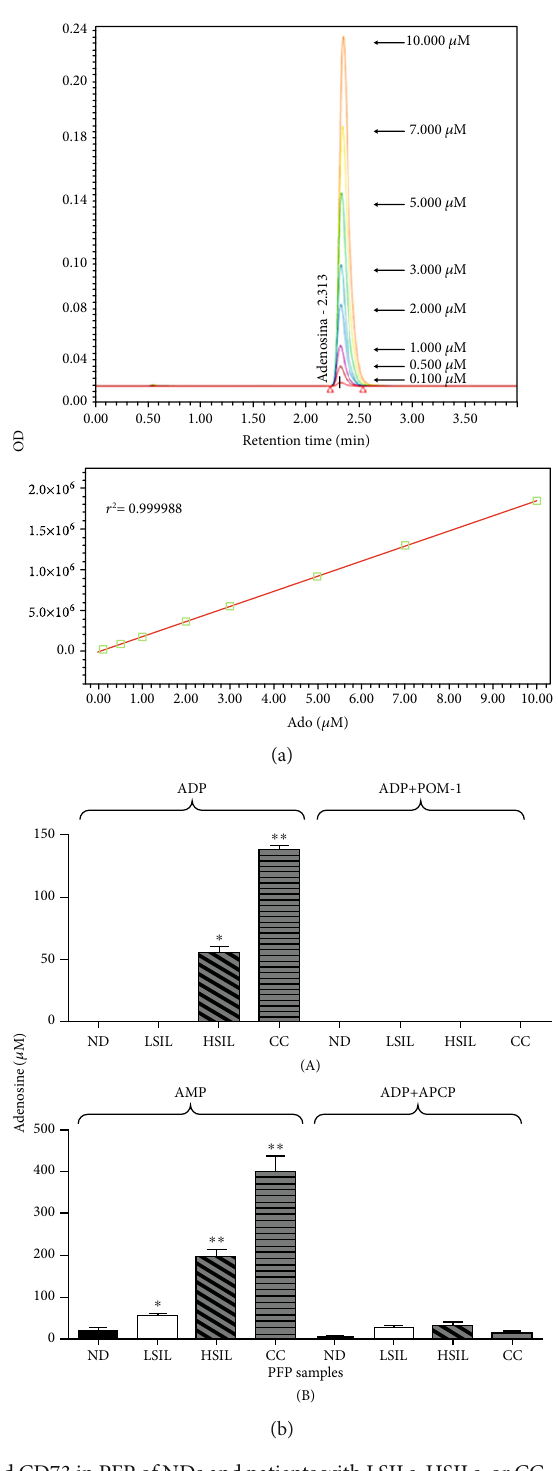
Figure 3: Catalytic activity of CD39 and CD73 in PFP of NDs and patients with LSILs, HSILs, or CC. Aliquots of 5 μ l of PFP from NDs (black bars), patients with LSILs (white bars), patients with HSILs (diagonal lines), and patients with CC (horizontal lines) were incubated in the presence of 5 mM ADP or AMP (total volume 100 μ l) and in the presence or absence of POM-1 or APCP, speci fi c inhibitors of CD39 and CD73, respectively. (a) The Ado produced by hydrolysis of the nucleotides was quanti fi ed after 72 h by UPLC using standard concentrations of synthetic Ado (upper). A representative linear relationship between the Ado concentration and the optical density is shown (lower). (b) The amount of Ado produced during the incubation of PFP with ADP (upper) or AMP (lower) and in the presence or absence of POM-1 or APCP is shown. Di ff erences in Ado concentrations were analyzed by two-way ANOVA. ∗ p < 0 : 01 , ∗∗ p < 0 : 0001 . The data represent three independent